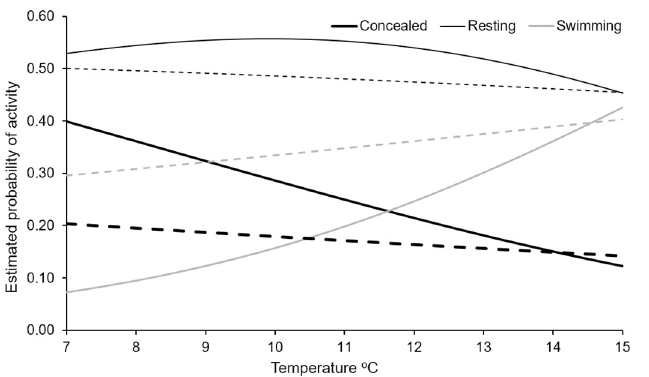
Fig 3. Estimated probability of concealed, resting, and swimming behavior of wild bull trout for large substrate and fluctuating temperatures in the ranges shown. Wild fish predictions assumed behavior occurred during dark for the 12 h light and 12 h dark (solid lines) and constant dark (dashed line)